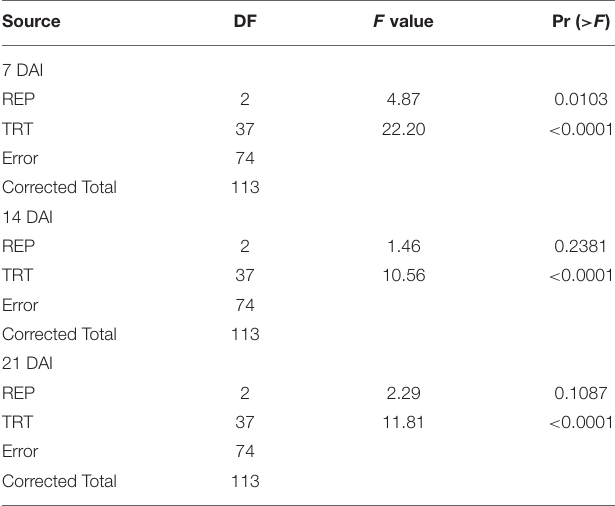
TABLE 4 | ANOVA for the leaf damage rating of maize germplasm on different days after infestation (DAI) in net house conditions.